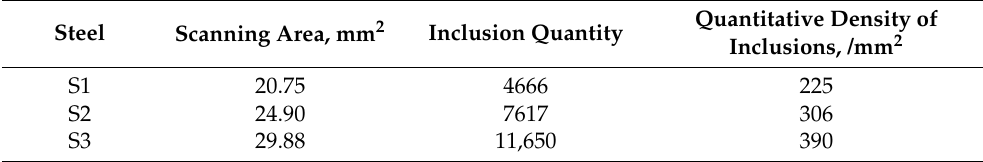
Table 2. The quantitative density of inclusions in samples.